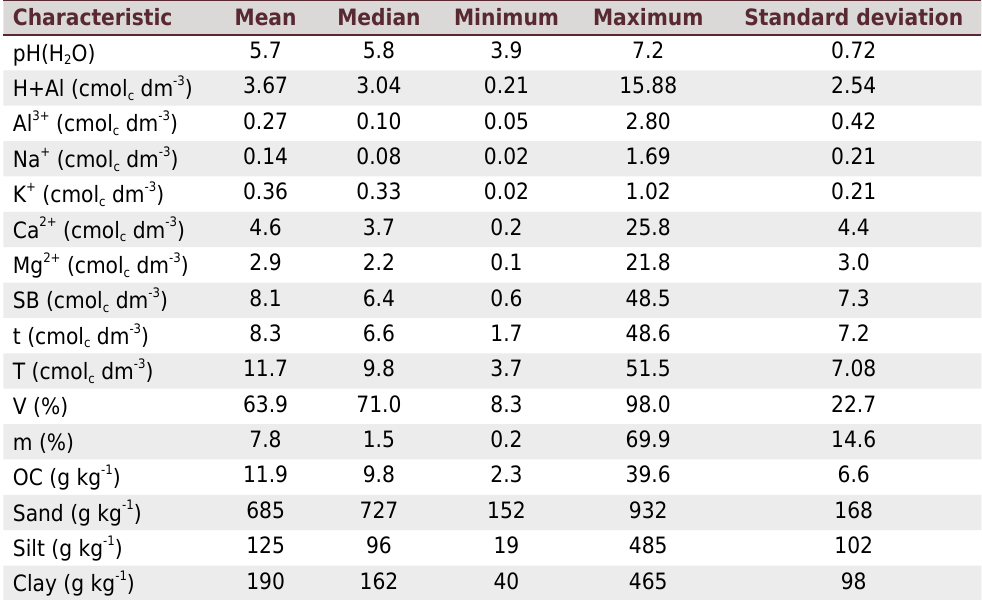
Table 2. Selected chemical and physical characteristics of the Paraíba State soil samples studied (n = 94)